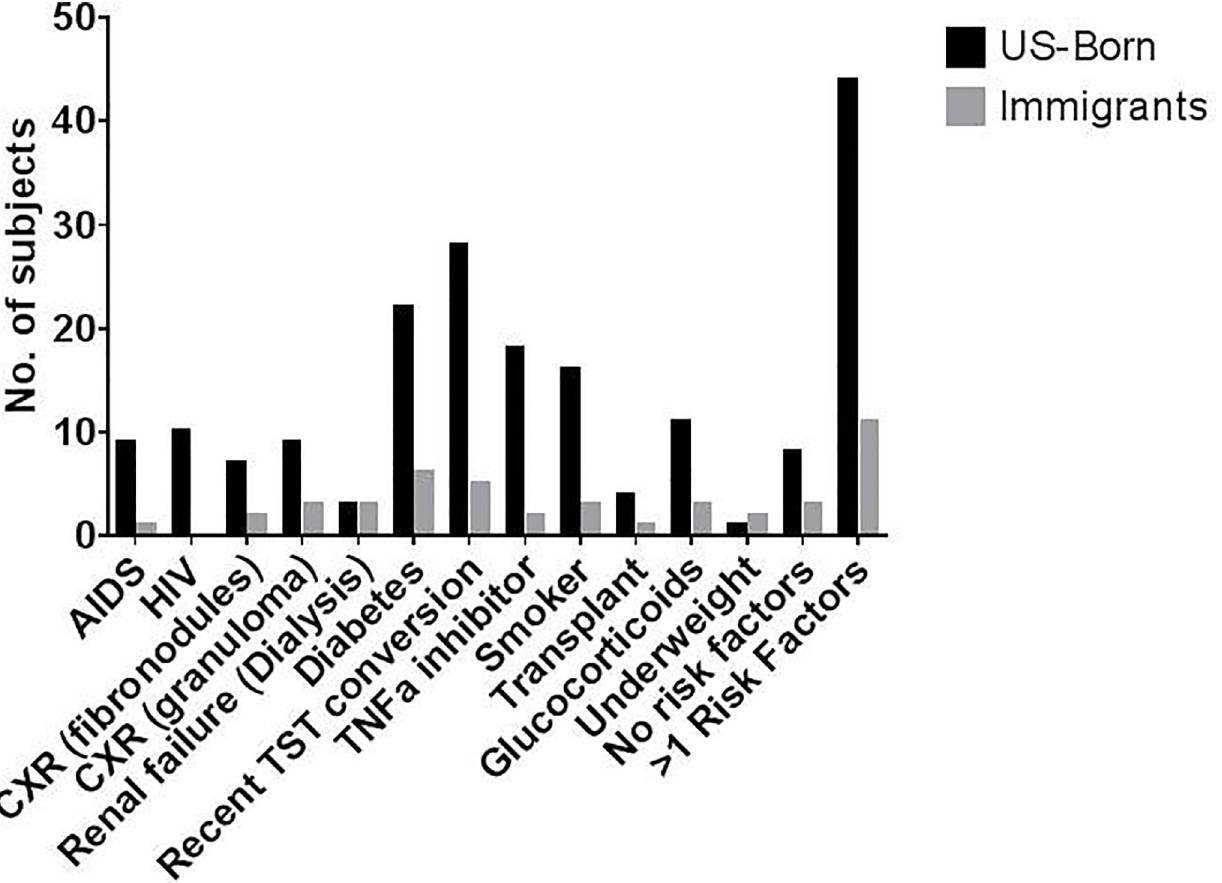
Fig 2. Showing number of US born (black bars) vs. non-US born (grey bars) subjects with different risk factors for progression to active TB disease in the overall cohort of patients with latent TB.